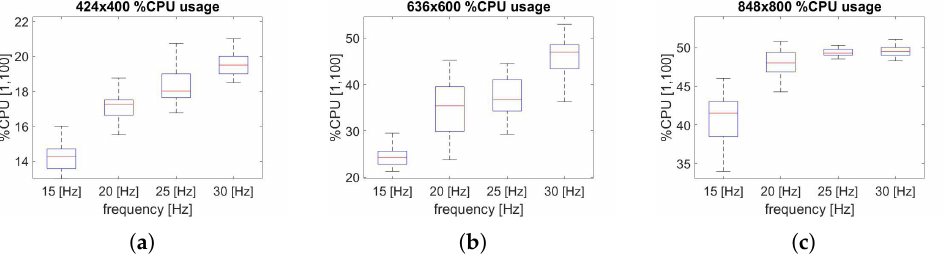
Figure 14. ( a ) CPU usage, 424 × 400; ( b ) CPU usage, 636 × 600; ( c ) CPU usage, 848 × 800. Jetson Nano board computational cost analysis along the trajectory performed by varying the